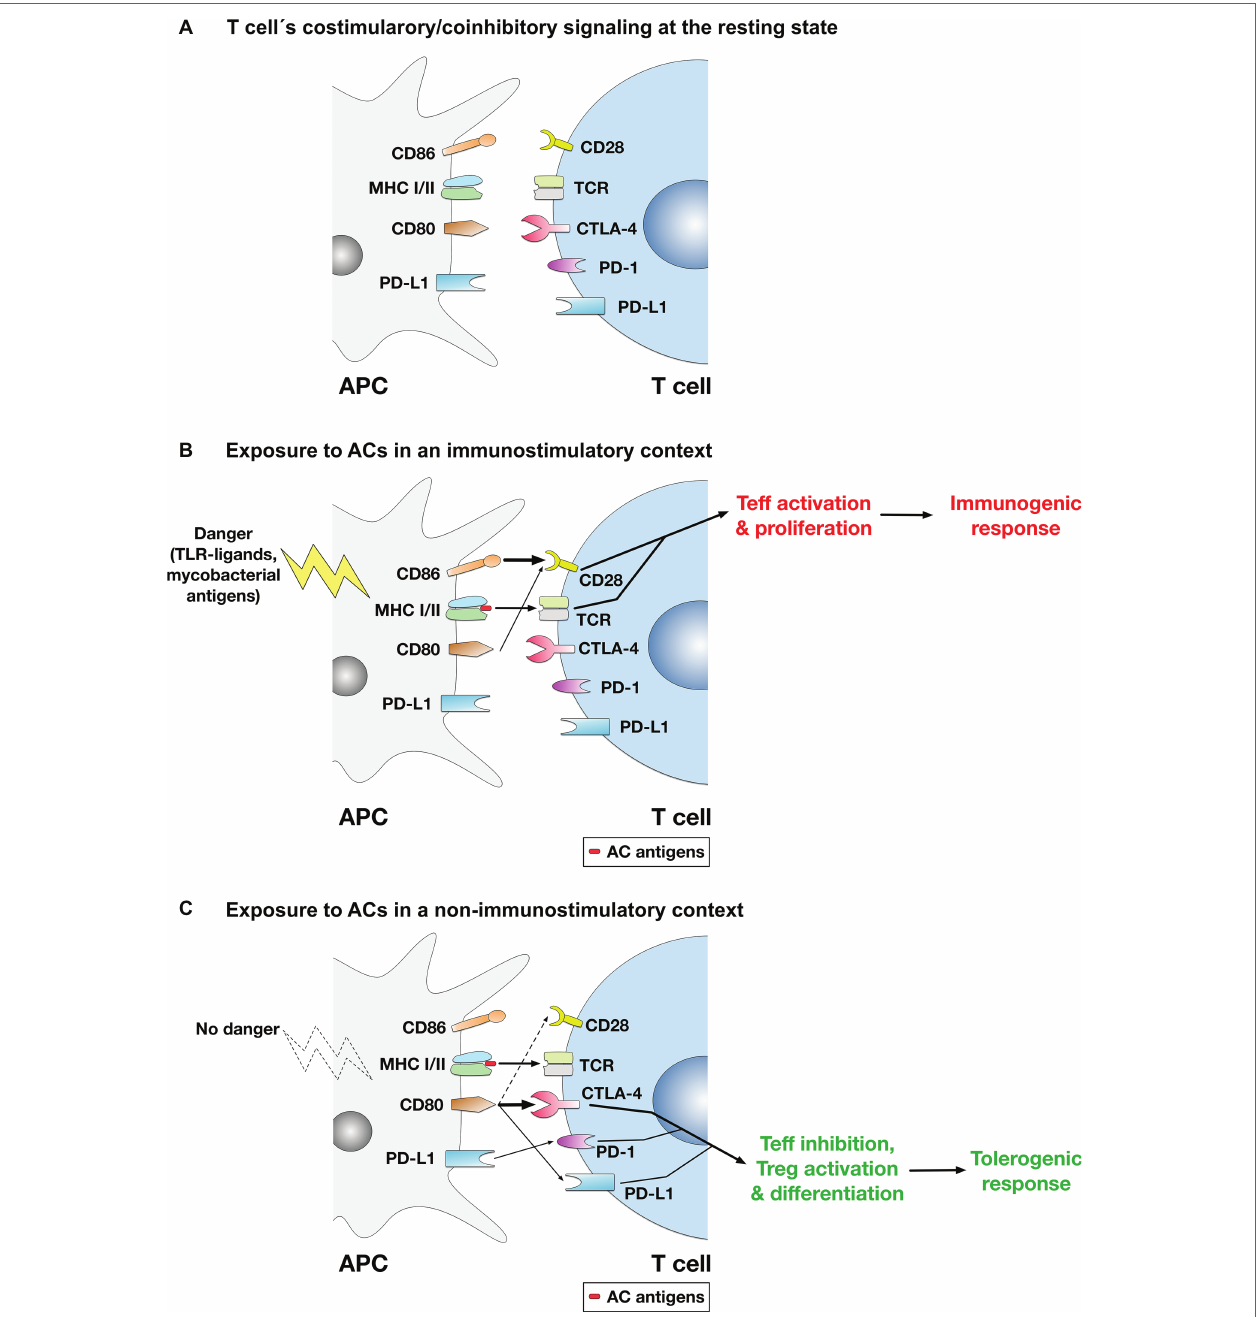
FIGURE 1 | A model for the regulation of T cell-mediated adaptive immune responses to apoptotic cells. (A) At the resting state, no activation of the TCR or the costimulatory pathway takes place. (B) In immunostimulatory contexts (such as AC ingestion by APCs in the presence of LPS, TLR ligands, or mycobacterial antigens), TCR binding to AC antigens presented in the context of MHC-I/II and the costimulatory signaling mediated by binding of CD28 by mainly CD86 (or CD86 and CD80) take place. Thus, activation of the costimulatory pathway ensures effector T cell (Teff) activation and proliferation, leading to mounting of an immune response to AC antigens. (C) In non-immunostimulatory contexts, such as AC ingestion by APCs in the absence of additional immunopotentiating stimuli (e.g., TLR ligands or mycobacterial antigens), the costimulatory signaling mediated by CD28 is downregulated. Rather, CD80 is upregulated, which binds mainly to CTLA-4 (CD80 binds CTLA-4 with much higher affinity than CD28), initiating the coinhibitory signaling that leads to Teff suppression and apoptosis. Even if some costimulatory signal is conveyed (by binding of some CD80 molecules to CD28), the